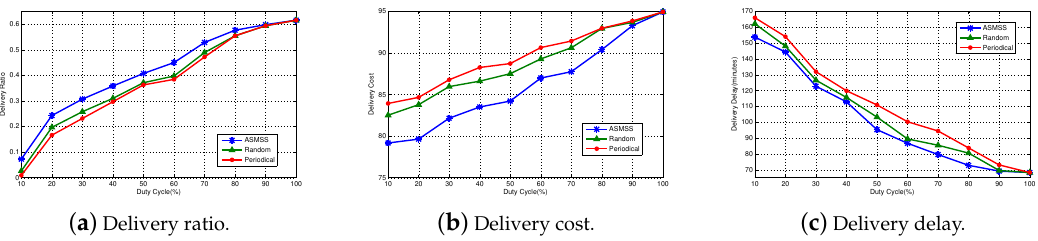
Figure 7. The comparison of delivery ratio ( a ), delivery cost ( b ) and delivery delay ( c ) based on the epidemic routing protocol in Infocom6 trace.